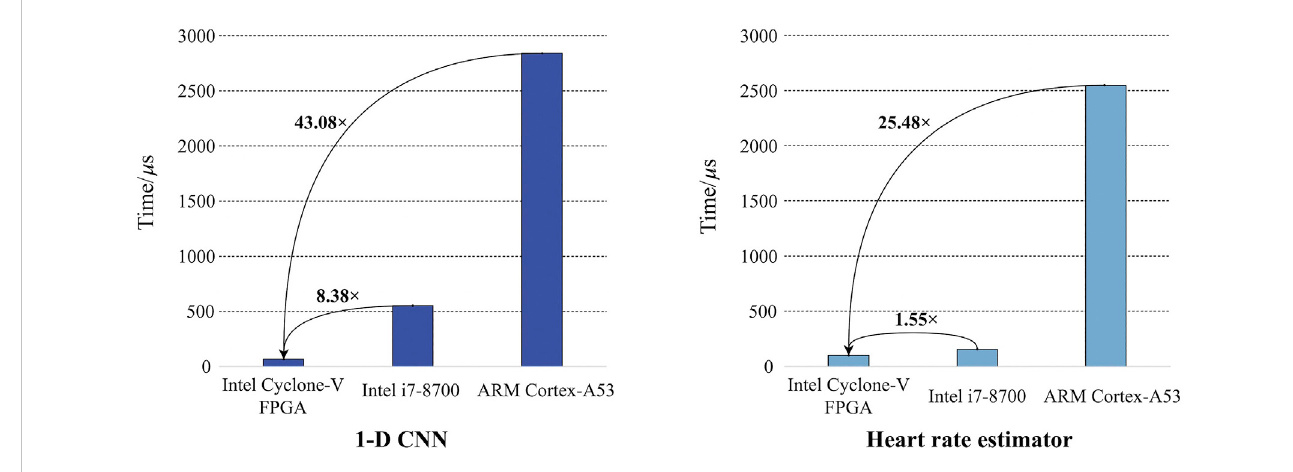
FIGURE 11 Acceleration performance for 1-D CNN and heart rate estimator.